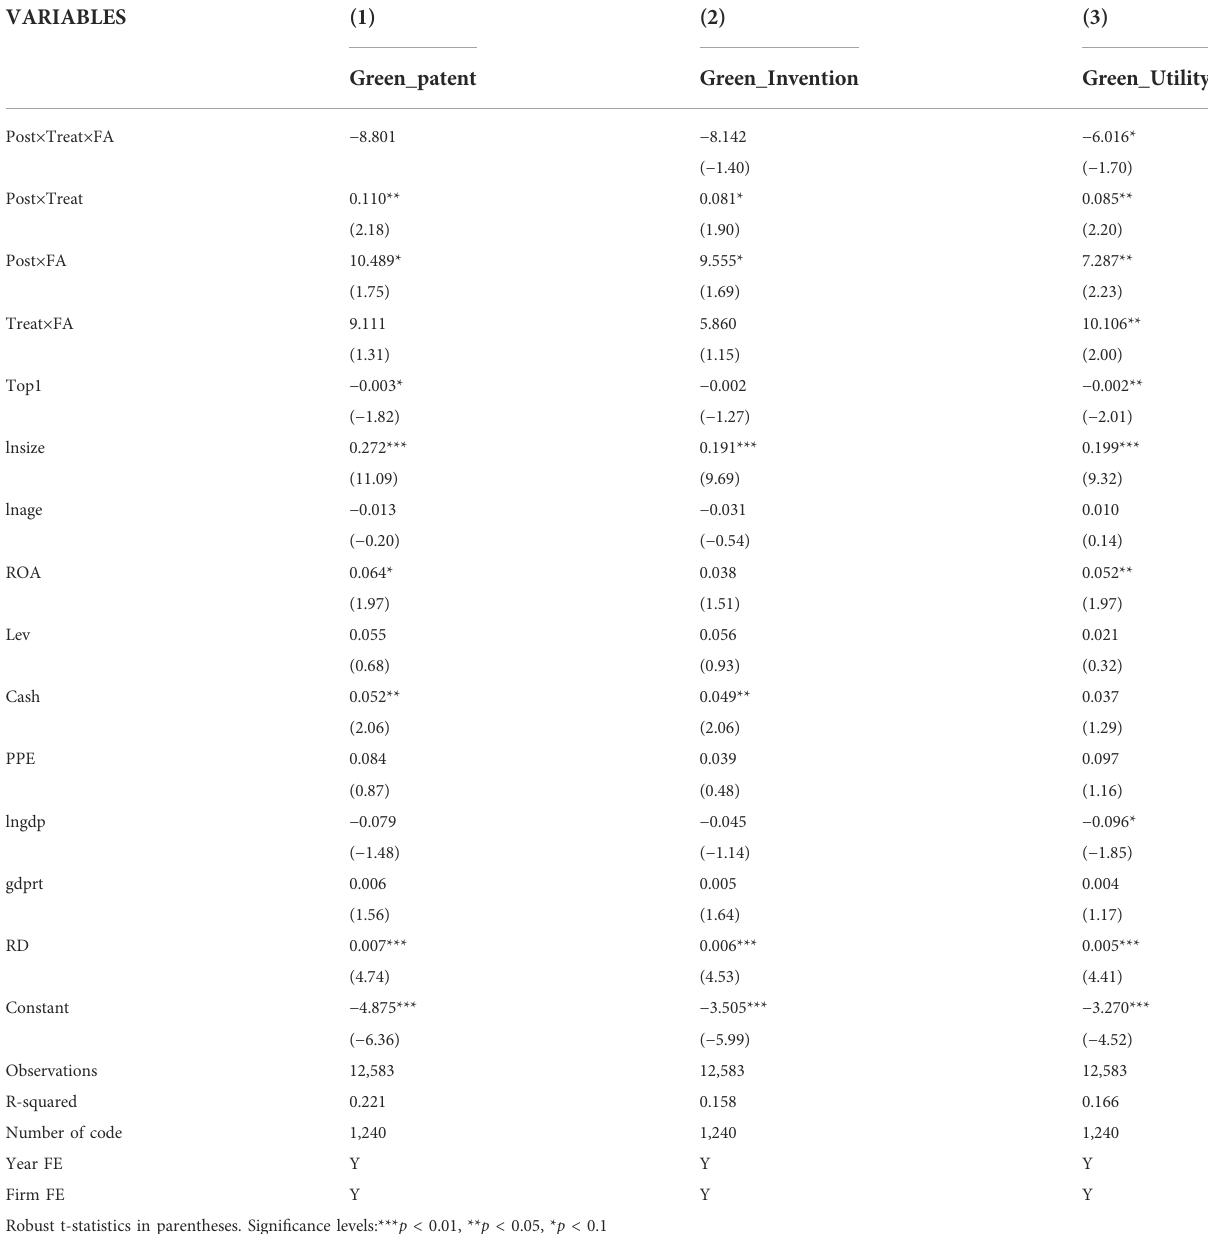
TABLE 6 Impact of low-carbon city pilot policy and fi nancial agglomeration on green innovation.